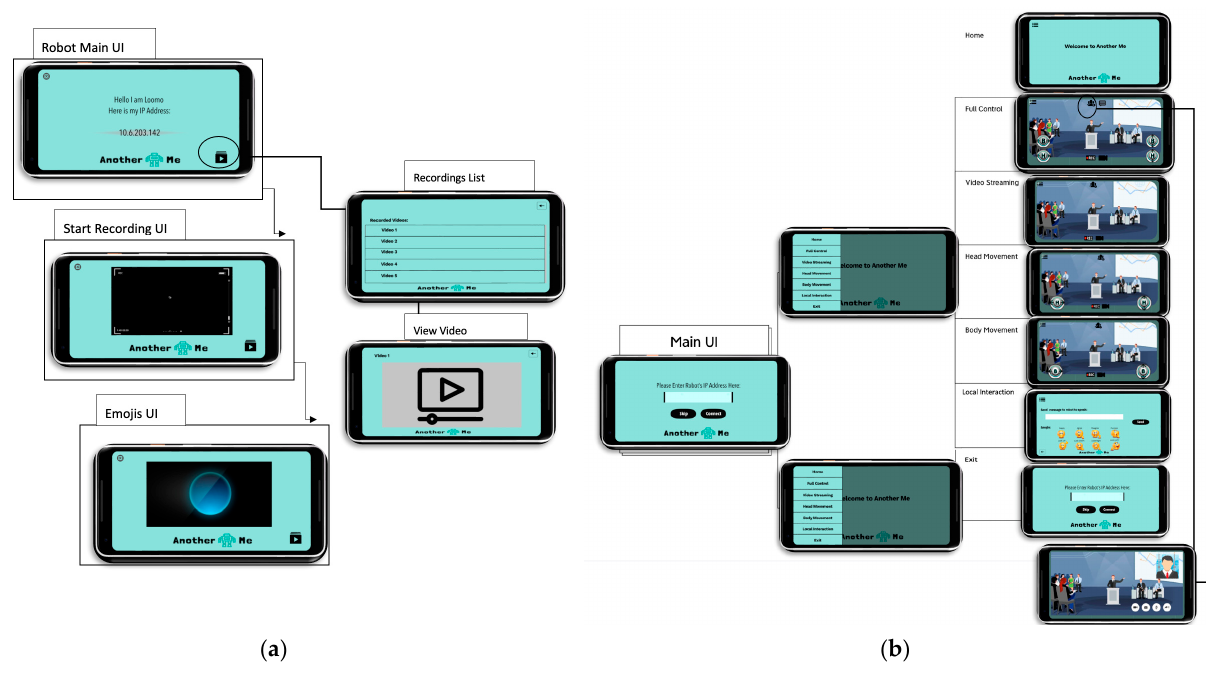
Figure 6. Components of the UI Layer. ( a ) Robot UI; ( b ) Mobile UI.